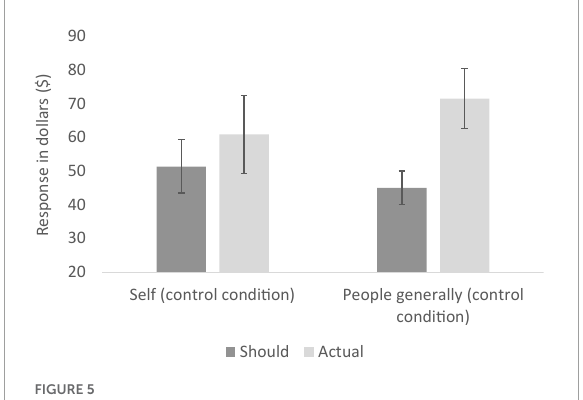
FIGURE5 Reported should and actual spends for clothes in the two control conditions (Experiment 3); error bars show 95% confidence intervals.